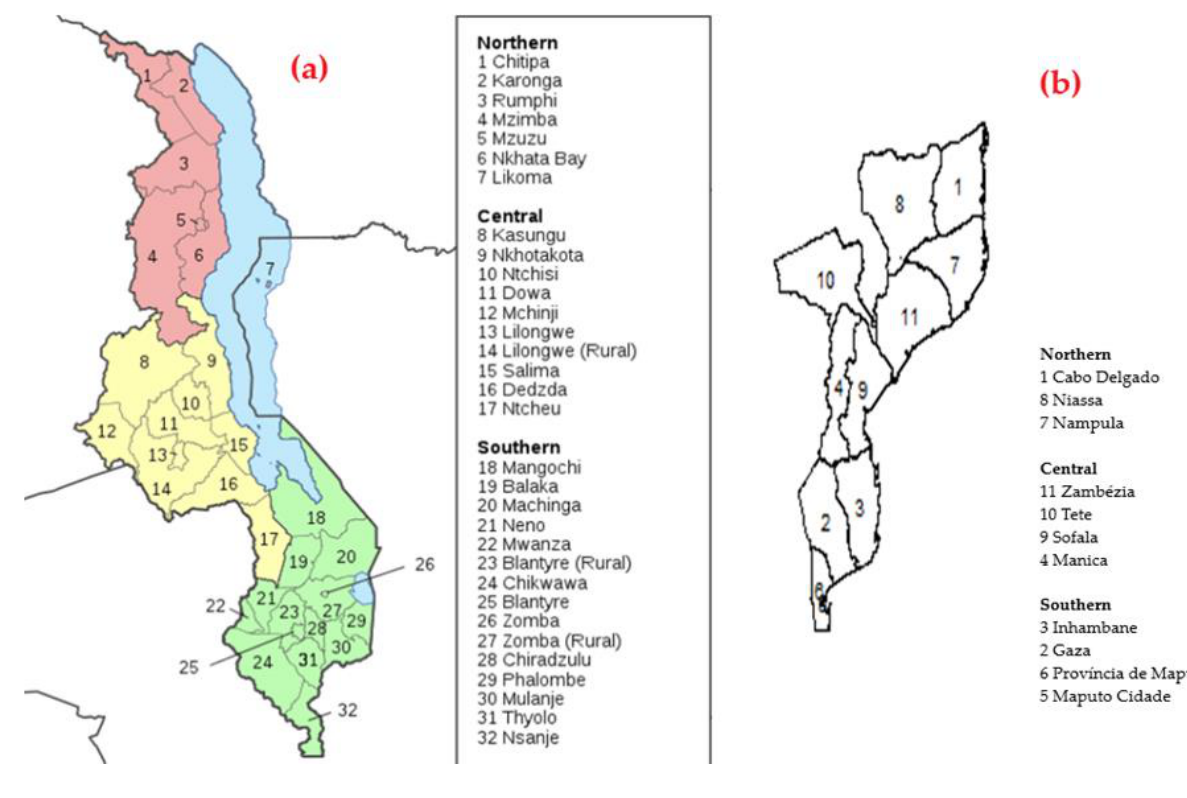
Figure 1. Map of Malawi showing the 32 districts ( a ) and map of Mozambique showing the 11 provinces ( b ).